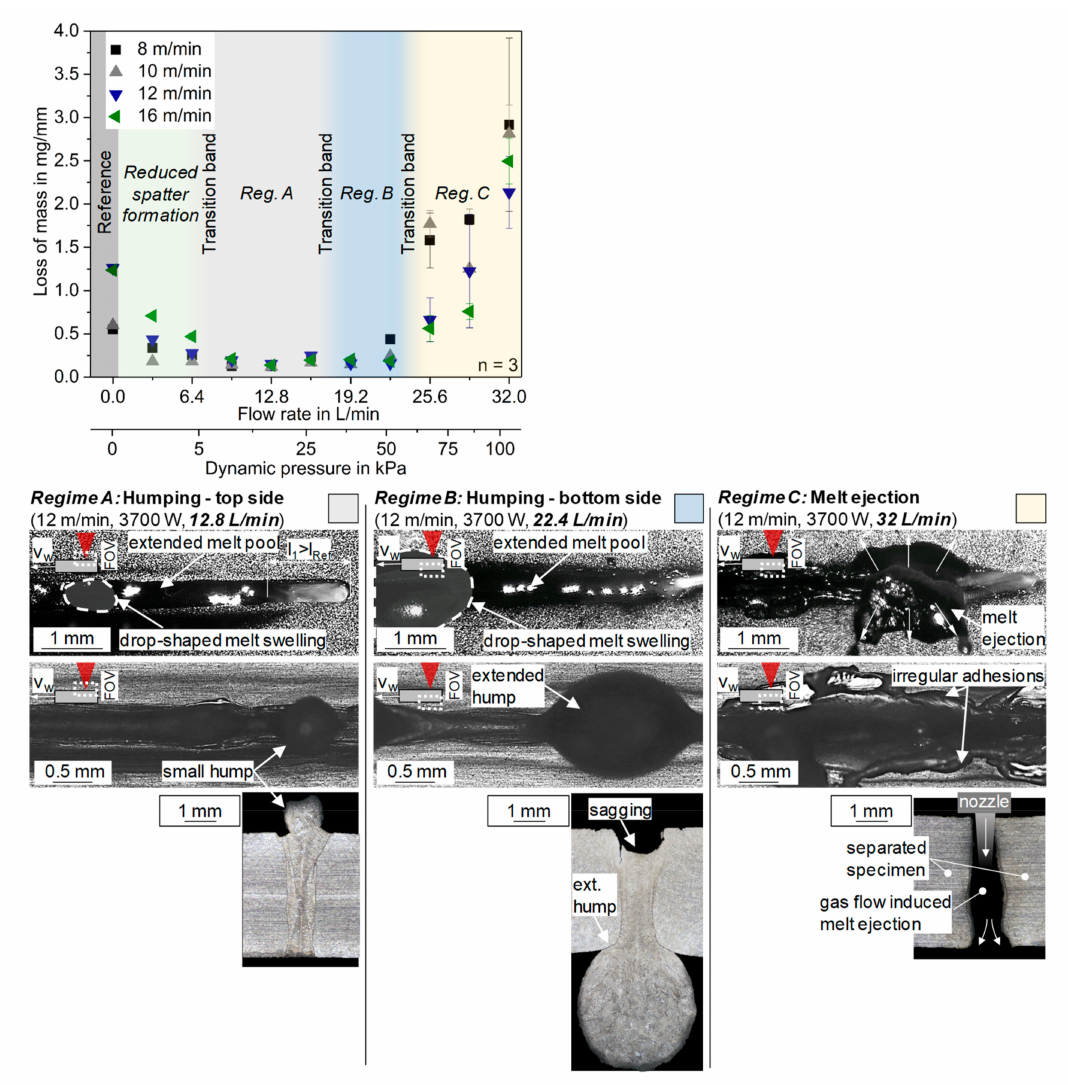
Figure 3. Process window of weld seam qualities depending on welding speed and flow